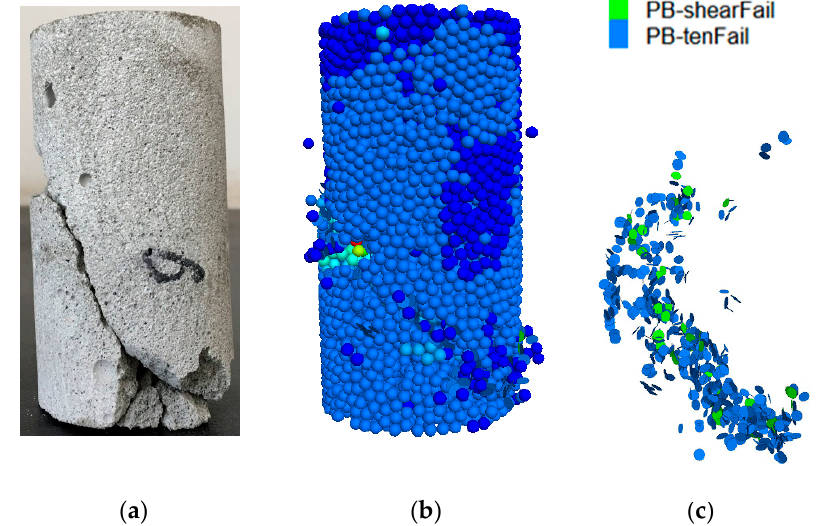
Figure 19. ( a ) damaged specimen after loading ( b ) failure mode of the numerical model ( c ) crack development inside the model.